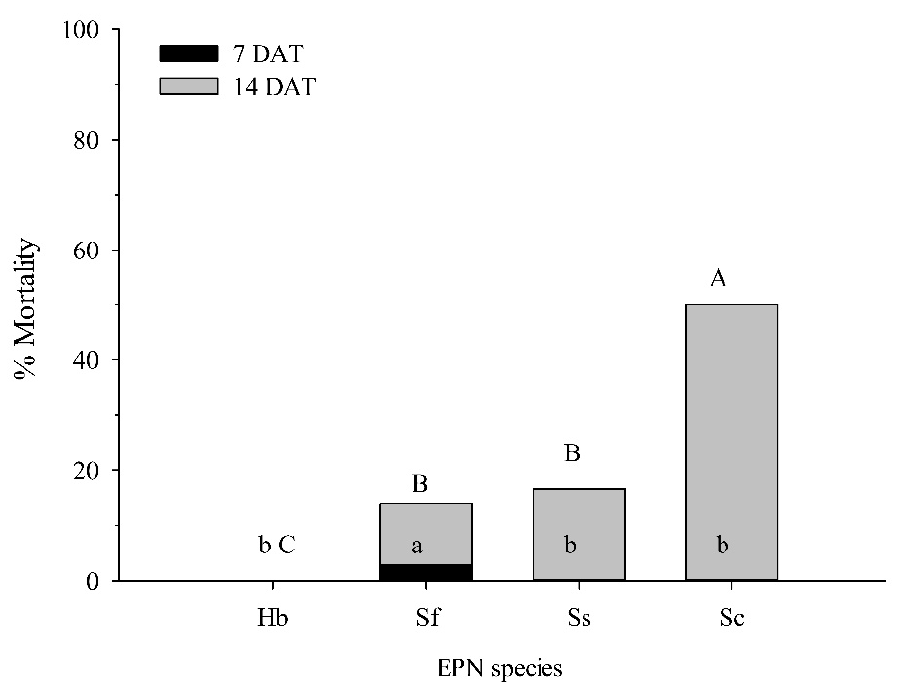
Figure 3. Percentage mortality (±SEM) of Conotrachelus nenuphar pupae at 7 and 14 days after treatment (DAT) with 400 infective juveniles of the entomopathogenic nematodes Steinernema carpocapsae (Sc), S. feltiae (Sf), S. scarabaei (Ss), and Heterorhabditis bacteriophora (Hb) in 30-mL cups with 20 g moist blueberry soil and one pupa. Bars with the same lower and uppercase letter do not differ significantly at 7 and 14 DAT, respectively ( p < 0.05).